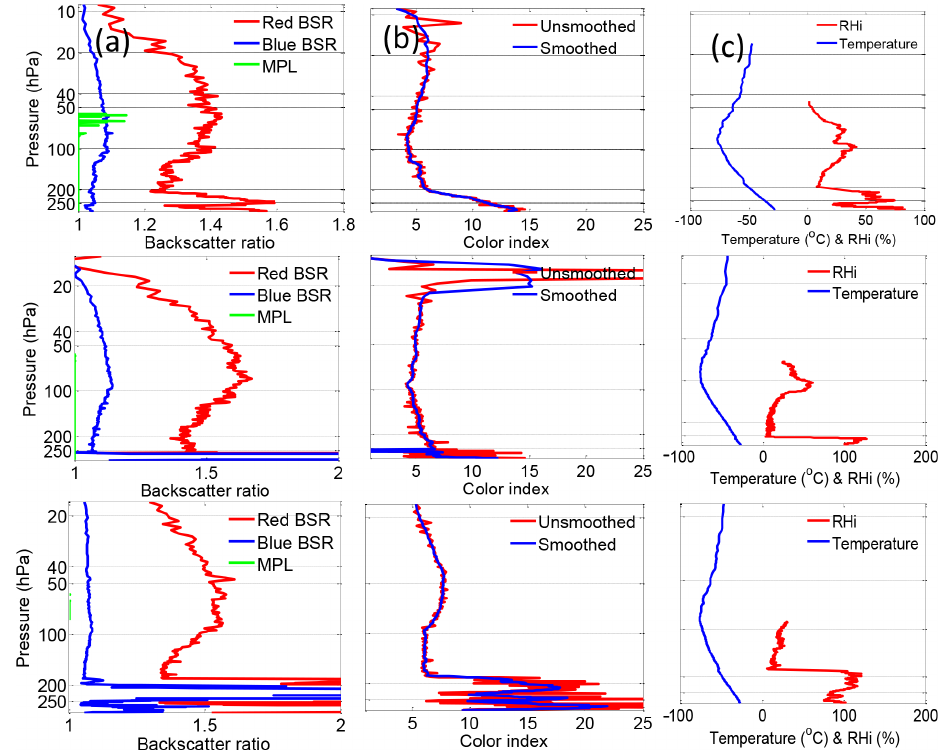
Figure 1. (a) Three cases of the backscattering ratio profile from COBALD and Micro Pulse Lidar (MPL) measurements on 18 June (top), 15 July (middle), and 25 July (bottom) in 2014. (b) The calculated CI profiles from the ABSR at two wavelengths. (c) Temperature and RHi profiles measured by the RS92 radiosonde and CFH,